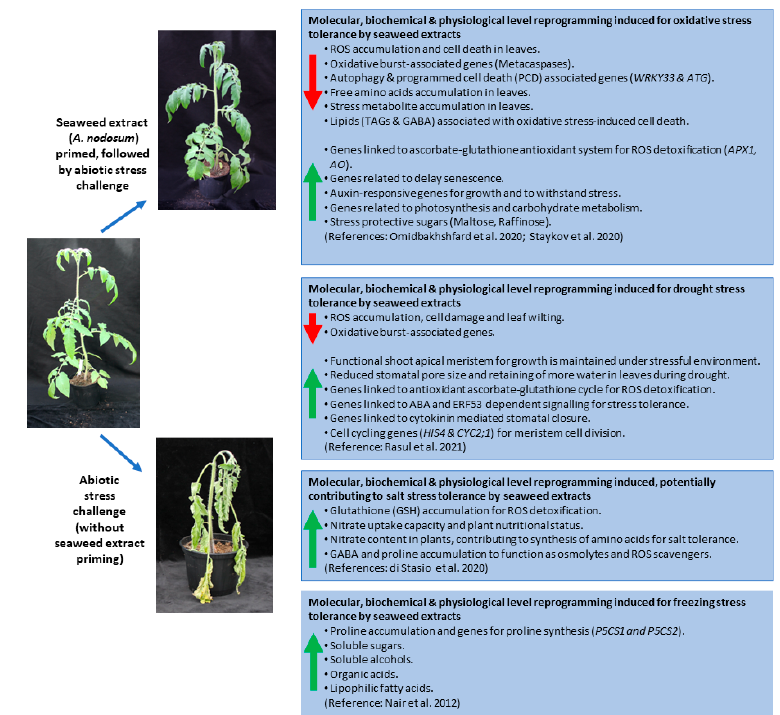
Figure 2. Commercially available A. nodosum -based seaweed extracts are proven to induce plant priming and abiotic stress tolerance in the model plant Arabidopsis and in crops. Molecular, bio- chemical and physiological level stress adaptations that occur in seaweed based biostimulant primed plants during oxidative, drought, salt and freezing stress challenges are also summarised above [144,155,165–167]. The tomato plants in the figure were primed with A. nodosum extract, Su- perFiffty, SF or untreated, with both treatment groups subsequently exposed to drought stress. Red and green arrows show processes, genes, metabolites that are repressed/downregulated and acti- vated/upregulated, respectively. 5.2. Seaweed Extracts-Based Abiotic/Oxidative Stress Reduction In a comprehensive study by Omidbakhshfard et al. [155], transcriptomic, metabo- lomic, and lipidomic data were collectively used to decipher the molecular mechanisms of oxidative stress tolerance induced by the seaweed biostimulant SF in Arabidopsis. In this experiment, SF was used in a foliar pretreatment step to prime the plants. Subse- quently, the oxidative stress inducing agent paraquat (PQ) was applied to generate ROS levels in planta , similar to those which occur during abiotic stress events. SF based plant